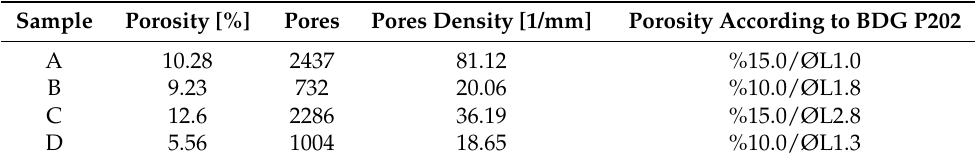
Table 4. Results obtained with the porosity analysis for the various samples.